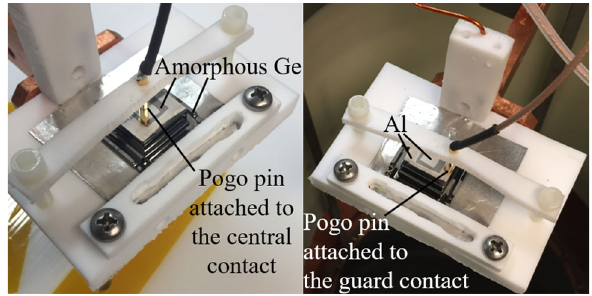
Fig. 10 Twodifferentcontactschemesoftheguard-ringdetectorUSD- R02 in the MPI